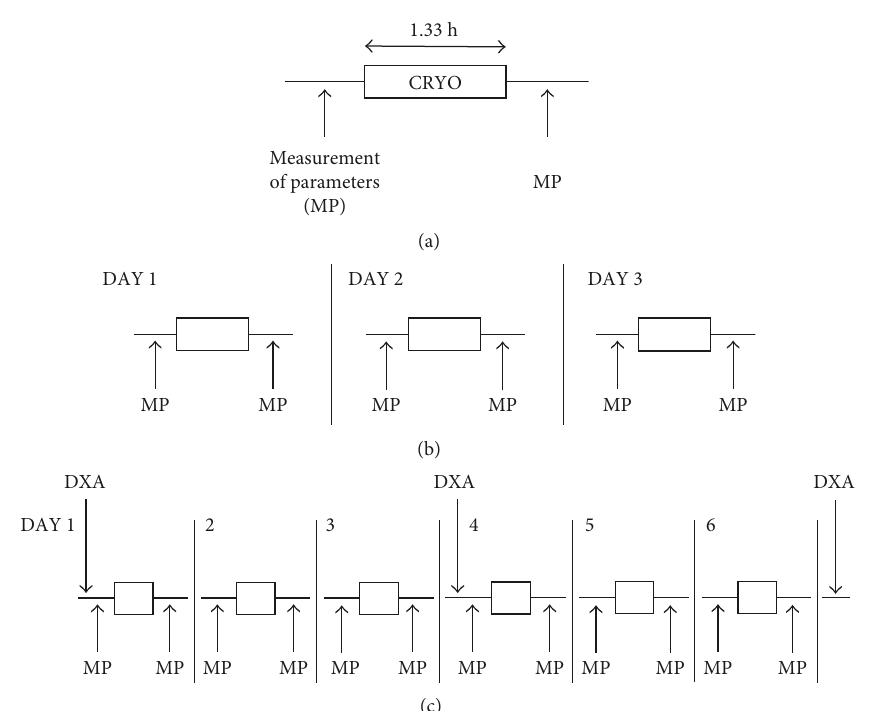
1.33h) in all procedures (not to scale in (cid:31) 7) underwent the procedure on 6 serial days; (cid:31)